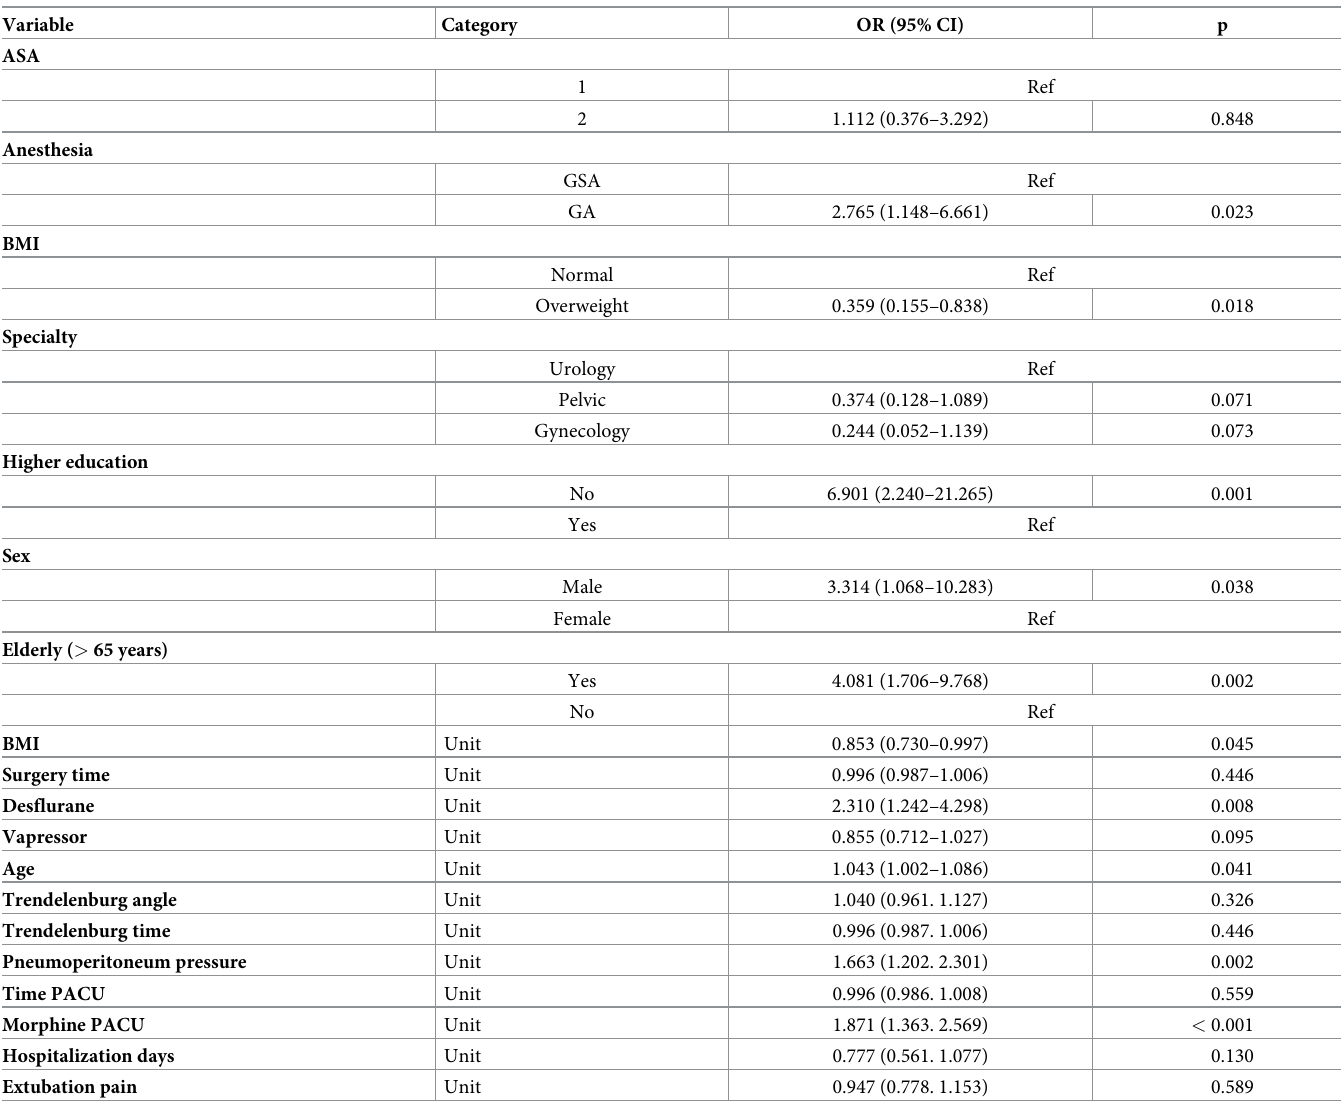
Table 4. Univariate logistic regression models of delirium